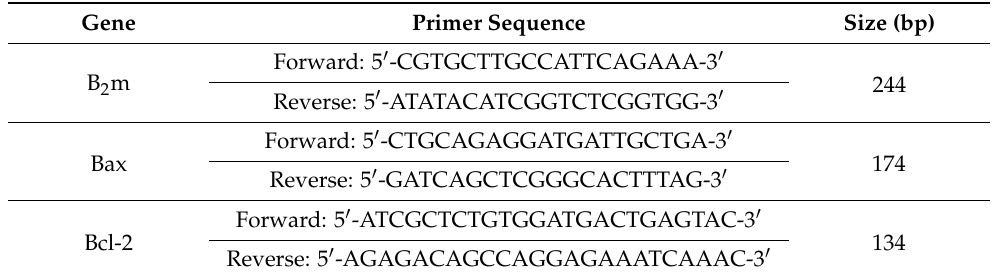
Table 2. The designed primers of the